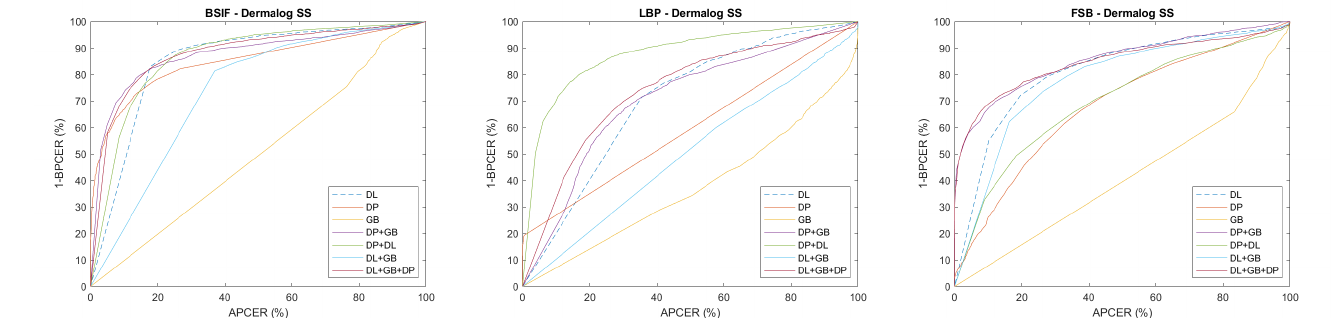
Figure 6. Comparison between ROCs of our self-trained PAD systems in an intra- (dashed) and cross- (solid) sensor scenario on the Dermalog Consensual dataset from LivDet 2021.